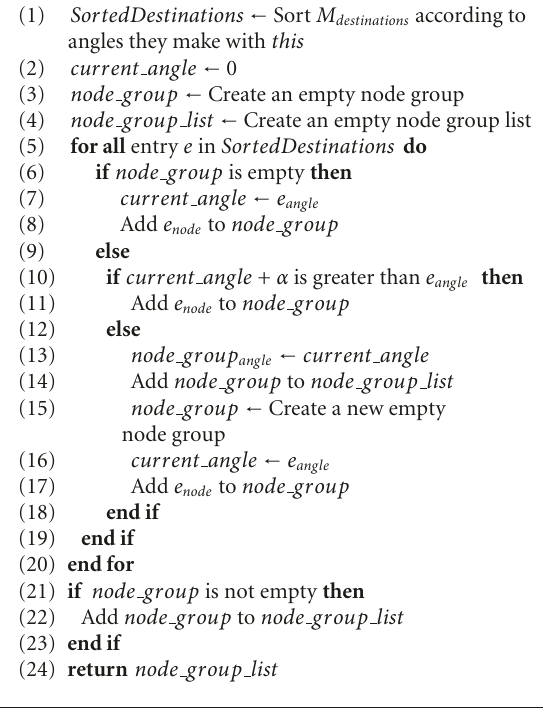
Algorithm 5: Grouping Destinations in